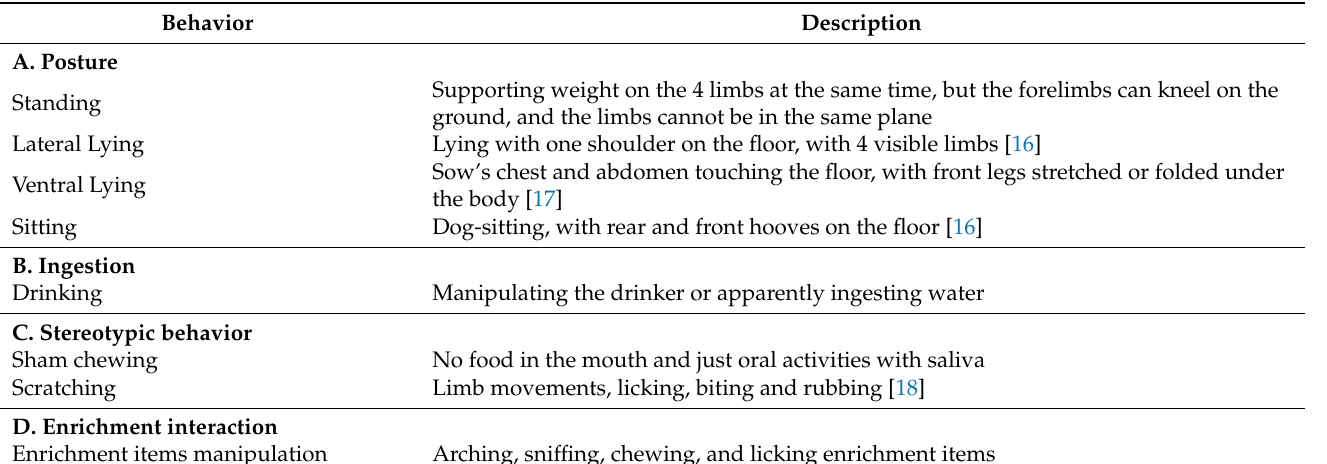
Table 2. Ethogram of behaviors used in the study.